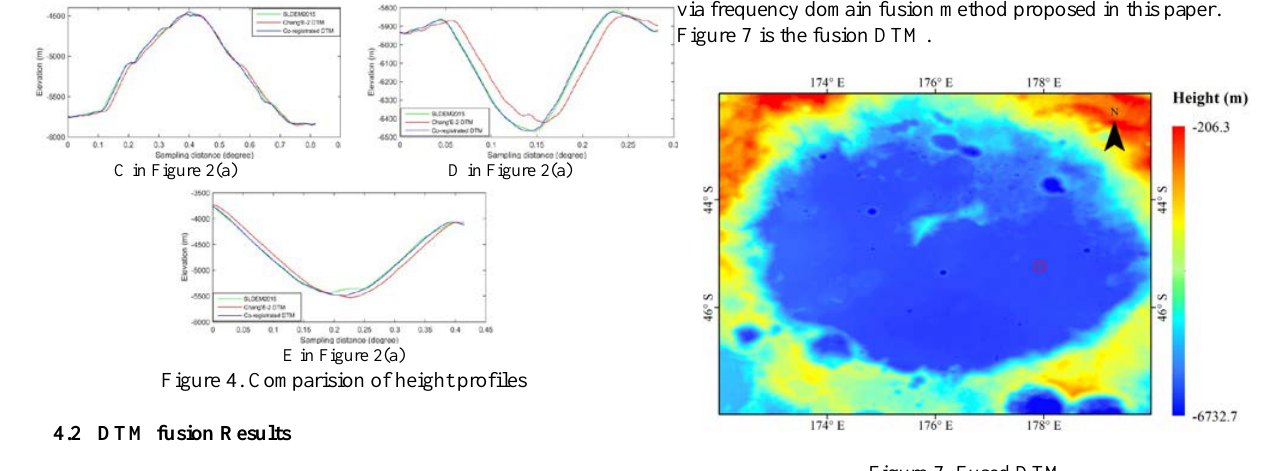
One hundred LROC NAC images were selected to generated the DOM. For the lacking coverage of LROC NAC images ， the 7m/pixel CE-2 DOM also used in some area for gap filling. The seamless DOM (Figure 9) covers an area of 2.3 ° in longitude and 1 ° in latitude, with a ground sample distance of 0.9